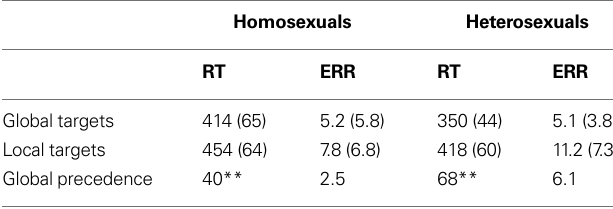
Table 3 | Mean reaction times (RTs, in ms) and error rates (ERRs, in %) for responses to globally and locally defi ned targets and the global precedence effect